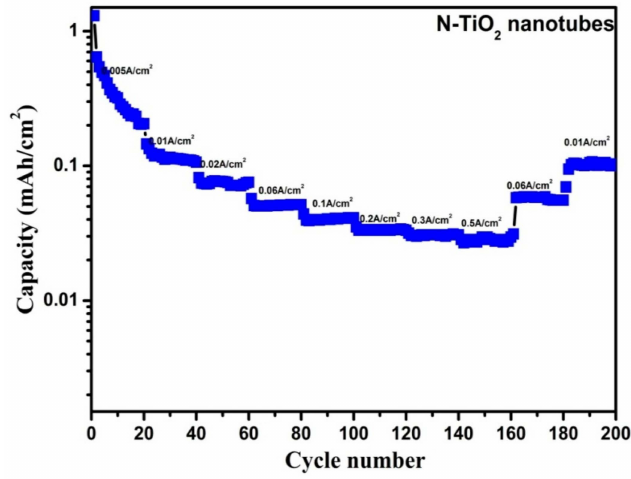
Figure 12. Rate capability performances of N-TiO 2